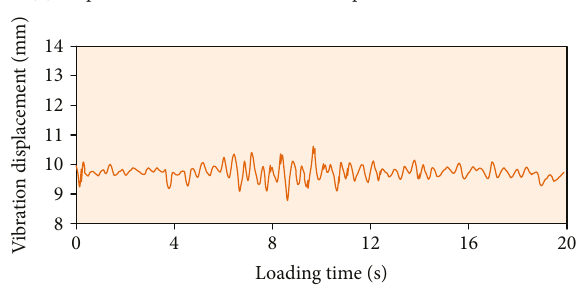
(c) Displacement time-interval curve of point 1 in direction Z Figure 21: Displacement time-interval curves of point 1 in directions X, Y, and Z.